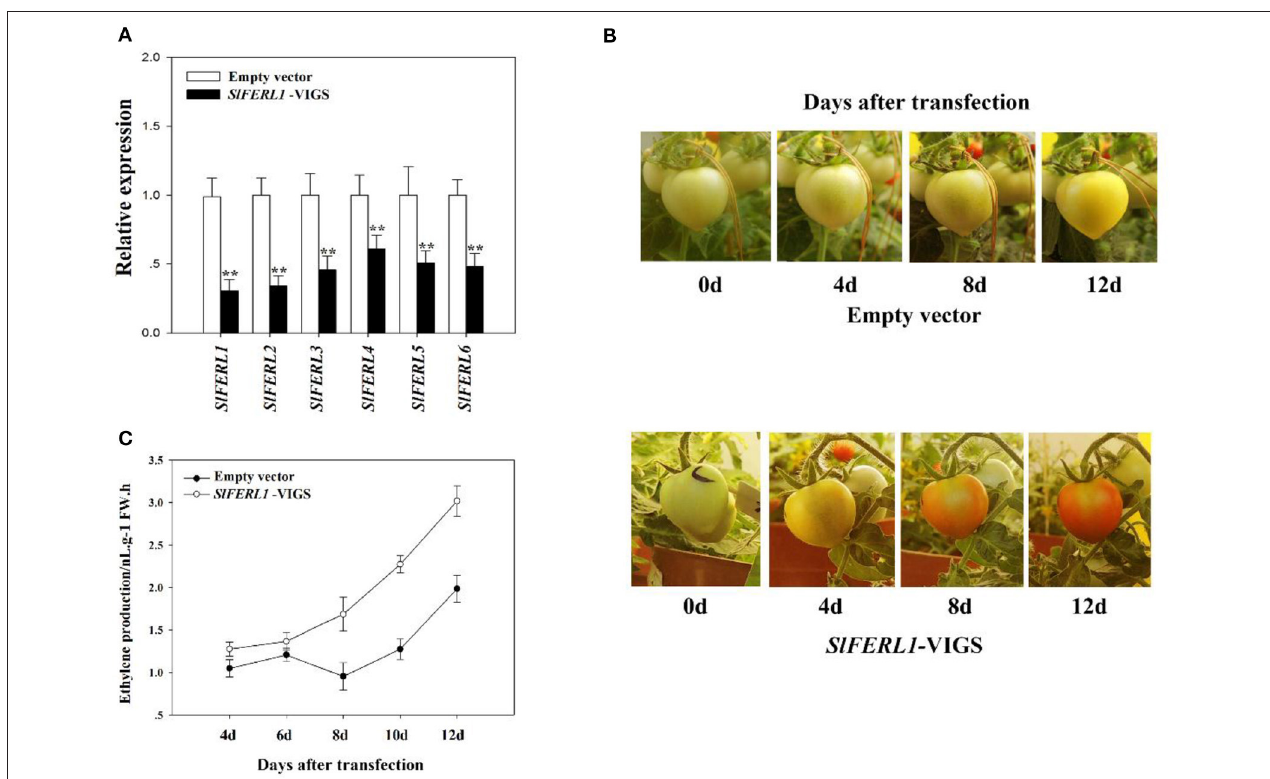
FIGURE 5 | Effect of SlFERL1 -VIGS (virus-induced gene silencing) on tomato fruit development and ripening. (A) The influence of SlFERL1 -VIGS on the expression of the other SlFERLs . RT-qPCR was conducted using SlACTIN as an internal control. Values are means + SD of three biological replicates. Double asterisks denote a significant difference at P < 0.01 using Student’s t -test. (B) The influence of SlFERL1 -VIGS on the time course of tomato fruit development and ripening. (C) Effect of SlFERL1 -VIGS on tomato fruit ethylene